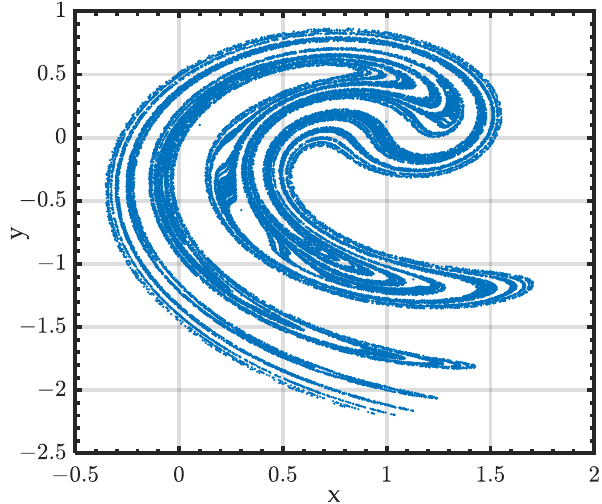
Figure 1. 2-D plot of the Ikeda map.